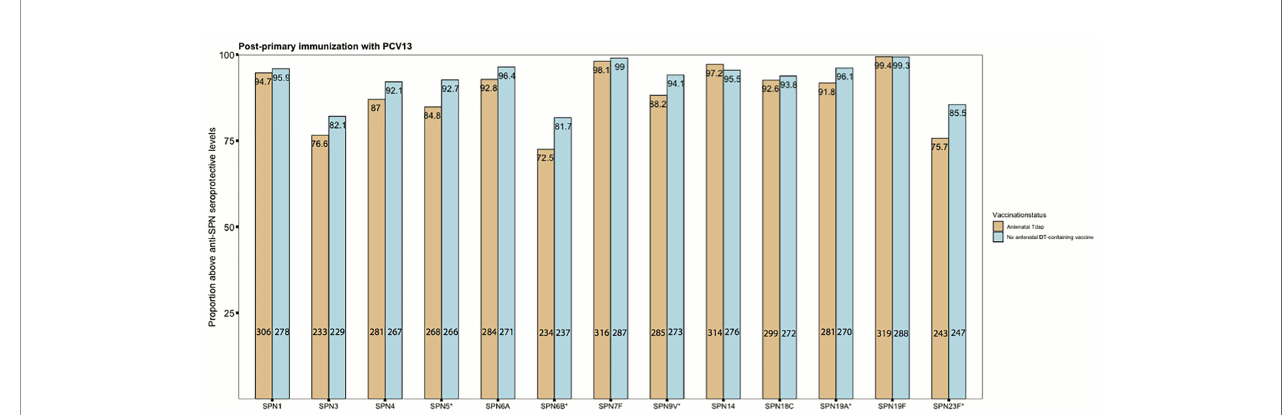
FIGURE 7 | Seroprotection rates against invasive pneumococcal disease. Rates of subjects with anti – streptococcus pneumonia (SPN) IgG levels ≥ 0.35 mg/mL in infants born to women immunized tetanus-diphtheria-acellular-pertussis (Tdap) versus infants of women not immunized with Tdap or diphtheria and tetanus toxoids vaccine in pregnancy after their primary immunization with pneumococcal conjugate vaccine 13 (PCV13) (*comparisons where p-values <0.05). Number of infants born to women Tdap-immunized and unimmunized in pregnancy was in the range of 304-323 and 279-290, respectively, for the different serotypes. P-values for the speci fi c serotypes: SPN1: p=0.642; SPN3: p= 0.13; SPN4: p= 0.057; SPN5: p= 0.004 ; SPN6A: p= 0.079; SPN6B: p= 0.009 ; SPN7F: p= 0.607; SPN9V: p= 0.016 ; SPN14: p= 0.358; SPN18C: p=0.661; SPN19A: p= 0.048 ; SPN19F: p=1; SPN23F: p=0.003 . Absolute numbers are shown in the bottom and percentages in the top of the bars. Seroprotection rates were compared using the chi-squared